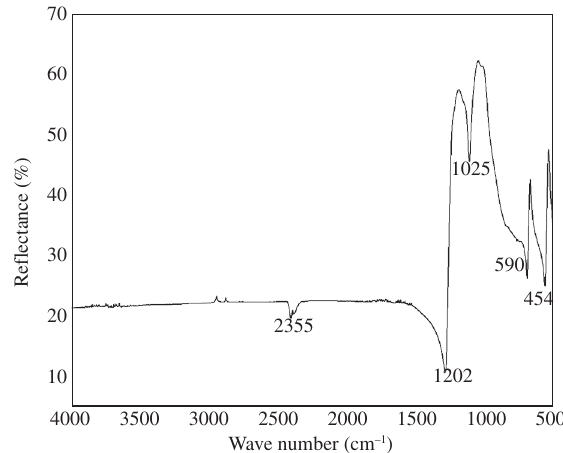
Figure 2. Diffuse reflectance infrared Fourier transformed (DRIFT) spectra of a silicon nitride sample without hydroxyapatite